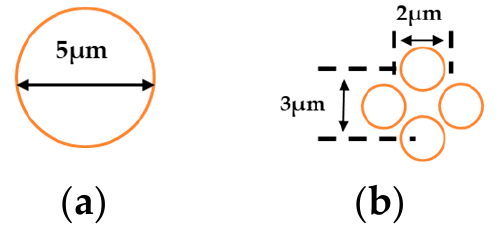
Figure 6. TSV structure. ( a ) Regular TSV; ( b ) New division TSV Structure.